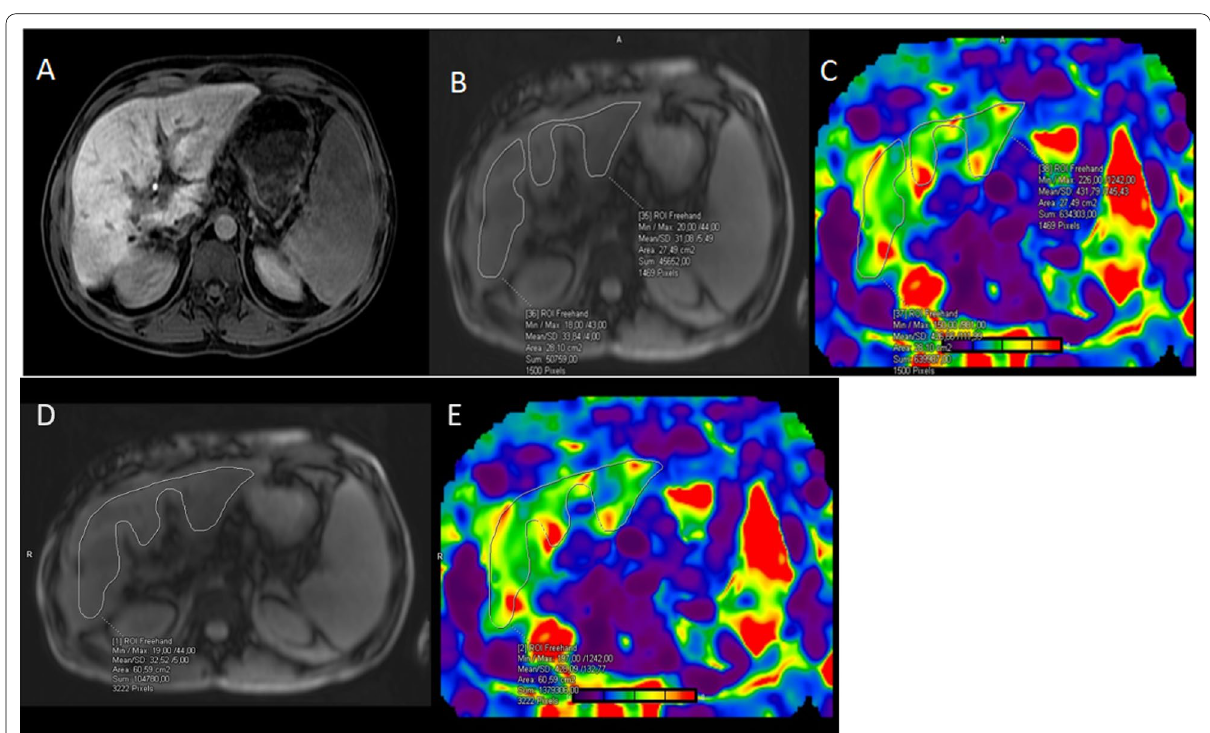
Fig. 2 Reticular hypointensity consistent with SOS in the hepatobiliary phase image ( A ). The magnitude image of the elastogram with ROIs for the right and left lobe ( B ). The corresponding ROIs on the elastogram; right lobe: 4.26 kPa, left lobe: 4.3 kPa ( C ). The magnitude image of the elastogram with ROIs for the total liver ( D ). The corresponding ROIs on the elastogram; MRE-LSM is 4.28 kPa ( E ).